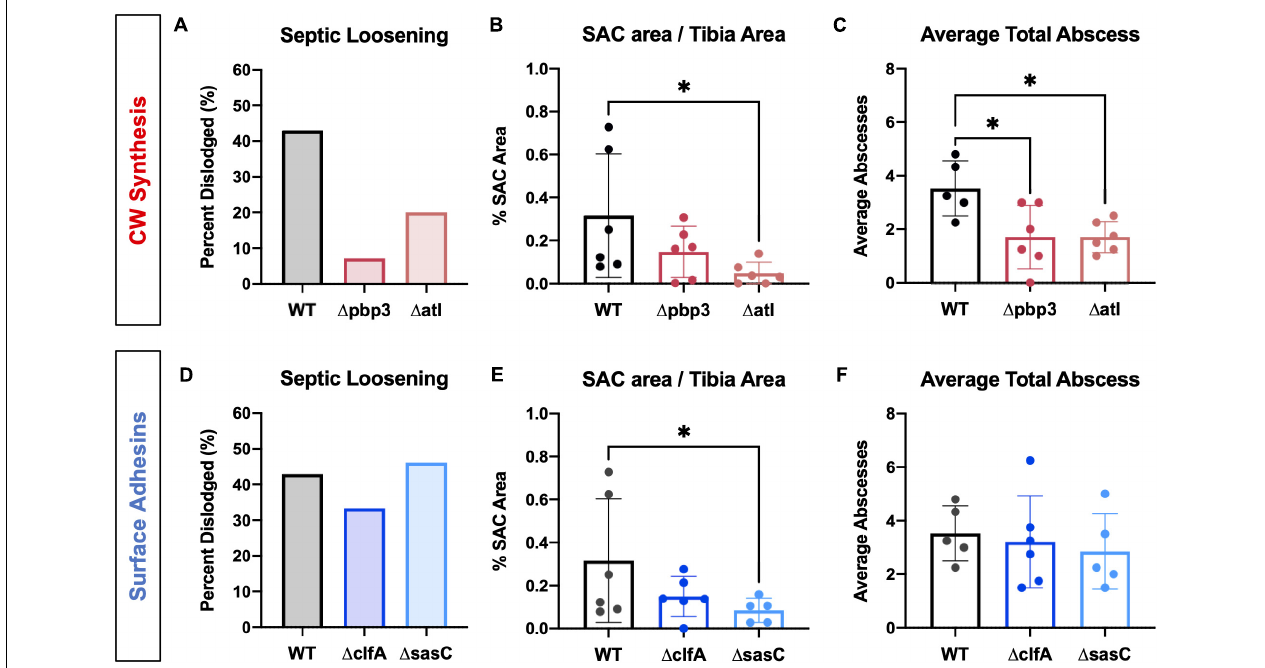
FIGURE 5 | Staphylococcus aureus cell wall synthesis mutants show diminished septic implant loosening and significantly decreased bone marrow abscess formation, while S. aureus surface adhesin mutants show minimal changes in pathogenesis. L-shaped wires contaminated with WT, (cid:49) pbp3, (cid:49) atl, (cid:49) clfA, and (cid:49) sasC S. aureus were surgically implanted through the tibia of mice as previously described. X-rays were obtained at the time of sacrifice to determine if the implant remained fixed or was dislodged from the tibia as a measure of septic implant loosening, as previously described (Masters et al., 2020) ( A , D ; n = 15). While not statistically significant by Fisher’s exact test, these data show that all cell wall biosynthesis mutants demonstrate diminished septic implant loosening compared to WT ( A , n = 15). Deletion of clfA or sasC did not affect septic implant loosening (D) . SAC area was quantified from Brown–Brenn–stained histologic sections using Visiopharm image analysis ( B , E ; n = 5–6), and average abscess number was quantified manually ( C , F ; evaluated by one-way ANOVA with Dunnett’s post-hoc test for multiple comparisons vs. WT, ∗ p < 0.05, n =